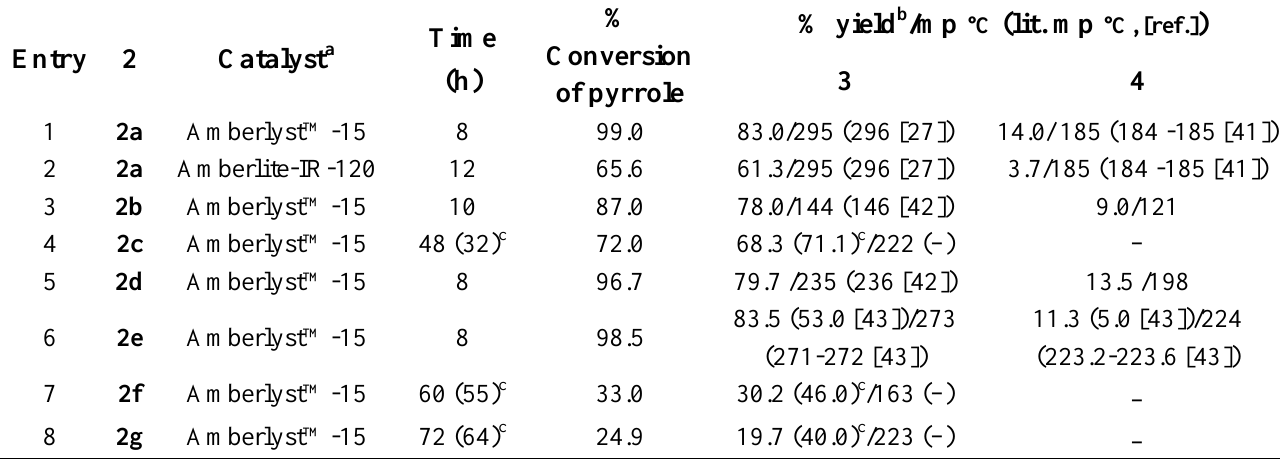
Table 2: Reaction of different ketones ( 2a-2g ) with pyrrole in DCM, catalyzed by Amberlyst™-15.